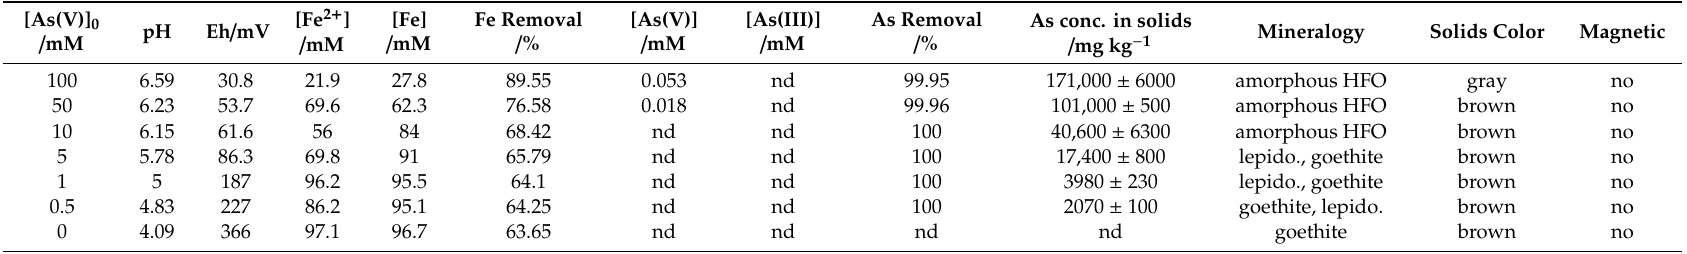
Table 1. Coprecipitation of As(V) with Fe(II) and Fe(III) in sulfate solutions (initial [Fe] 0 = 266 mM, nd = non-detect, HFO = hydrous ferric oxide).